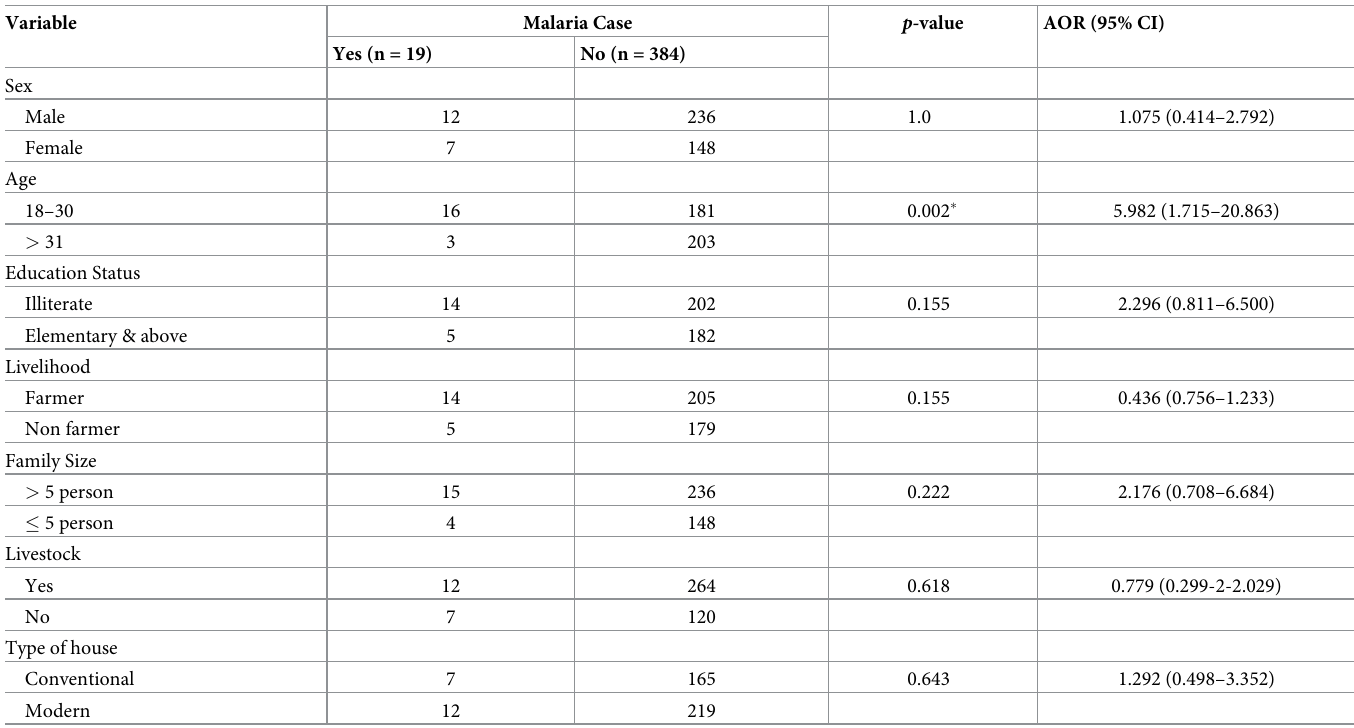
Table 6. Logistic regression analysis of factors associated with malaria case (n =